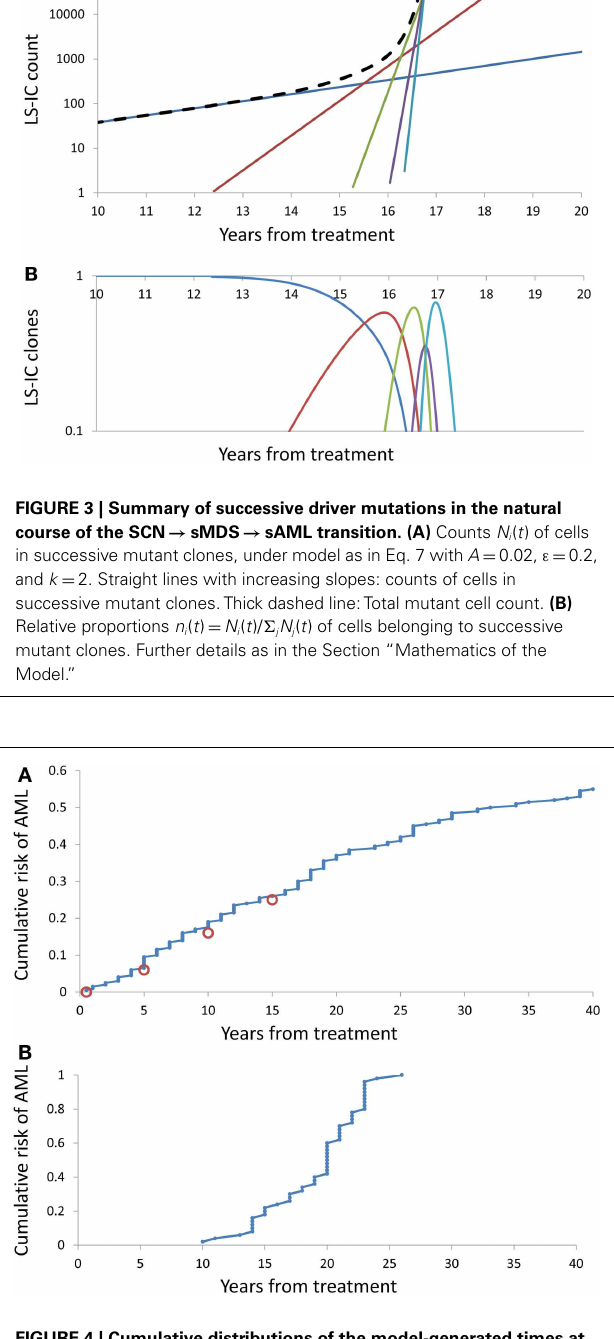
of the times at sAML diagnosis under model as in Eq. 7 with κ = 2, ε = 0.02, and A generated from the distribution in Eq. 8 with α = − 0.655 and β = −